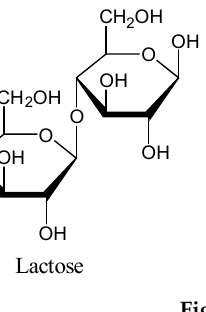
Figure 1. Enzymatic hydrolysis and synthesis of lactose.